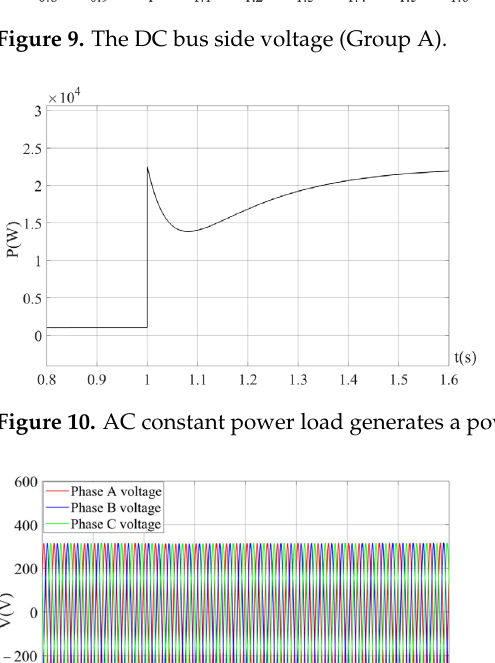
Figure 12. Three ‐ phase currents of AC bus (Group A). Group B’s simulation findings are depicted in Figures 13–16. Unfortunately, the DC bus voltage oscillates and cannot keep stable during the same power step of AC CPL, as shown in Figure 14. Simultaneously, considerable oscillations appear in the curves of AC bus three ‐ phase voltages and currents based on Figures 15 and 16. It is concluded that the parameter of Group B could not keep AC microgrids stable during large disturbances. Figure 13. The DC bus side voltage (Group B). Figure 14. AC constant power load generates a power step (Group B).